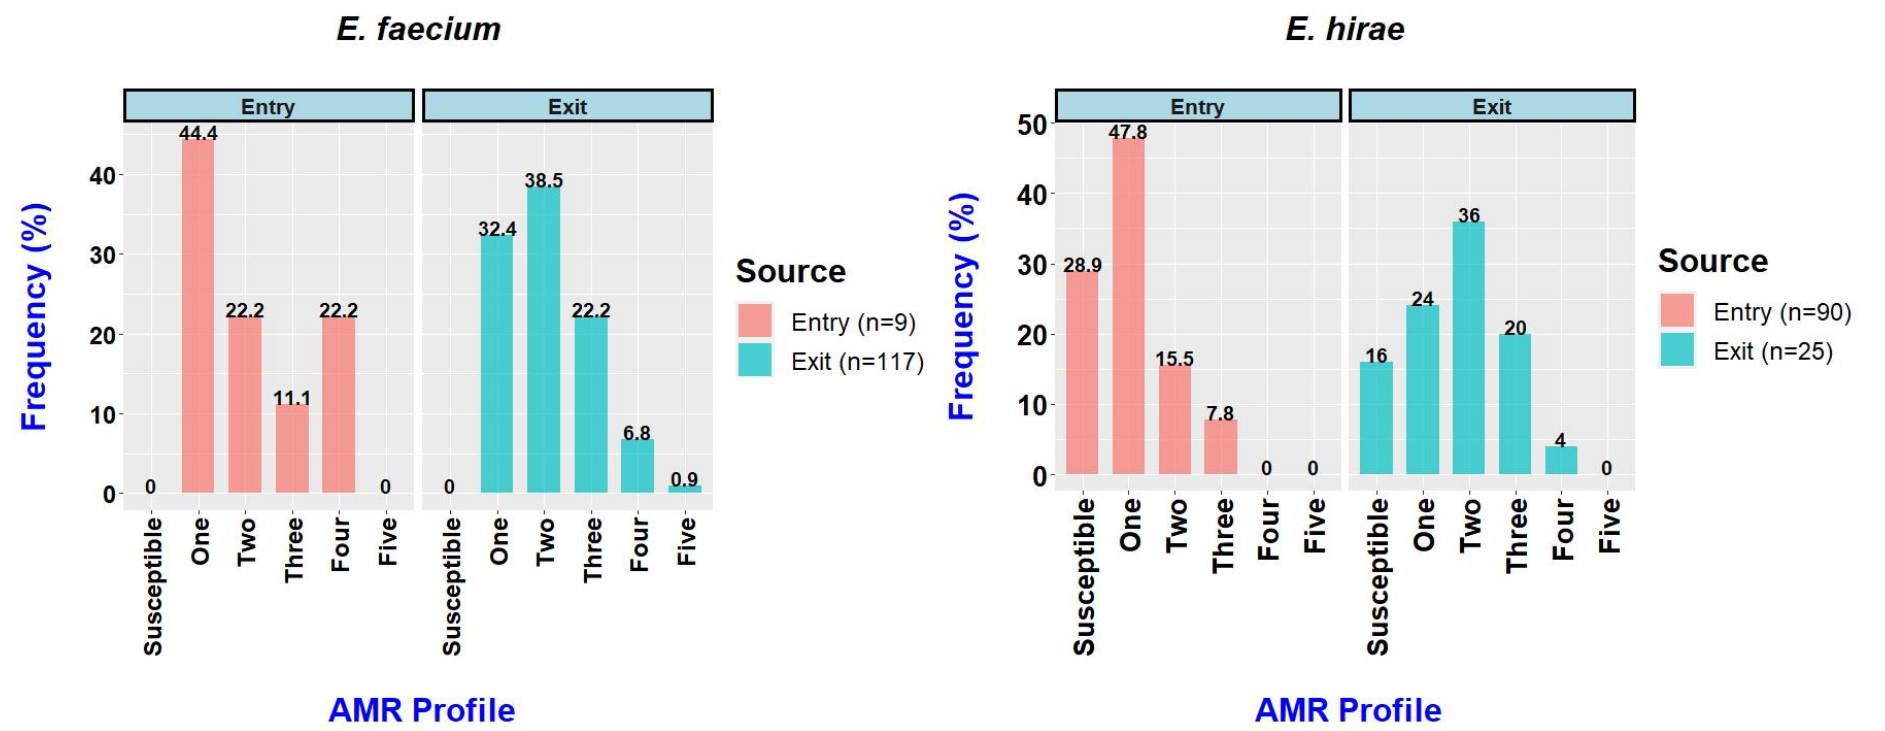
Figure 2. Frequency of Enterococcus faecium and Enterococcus hirae isolates from feedlot cattle faecal samples at entry and exit to the feedlot.